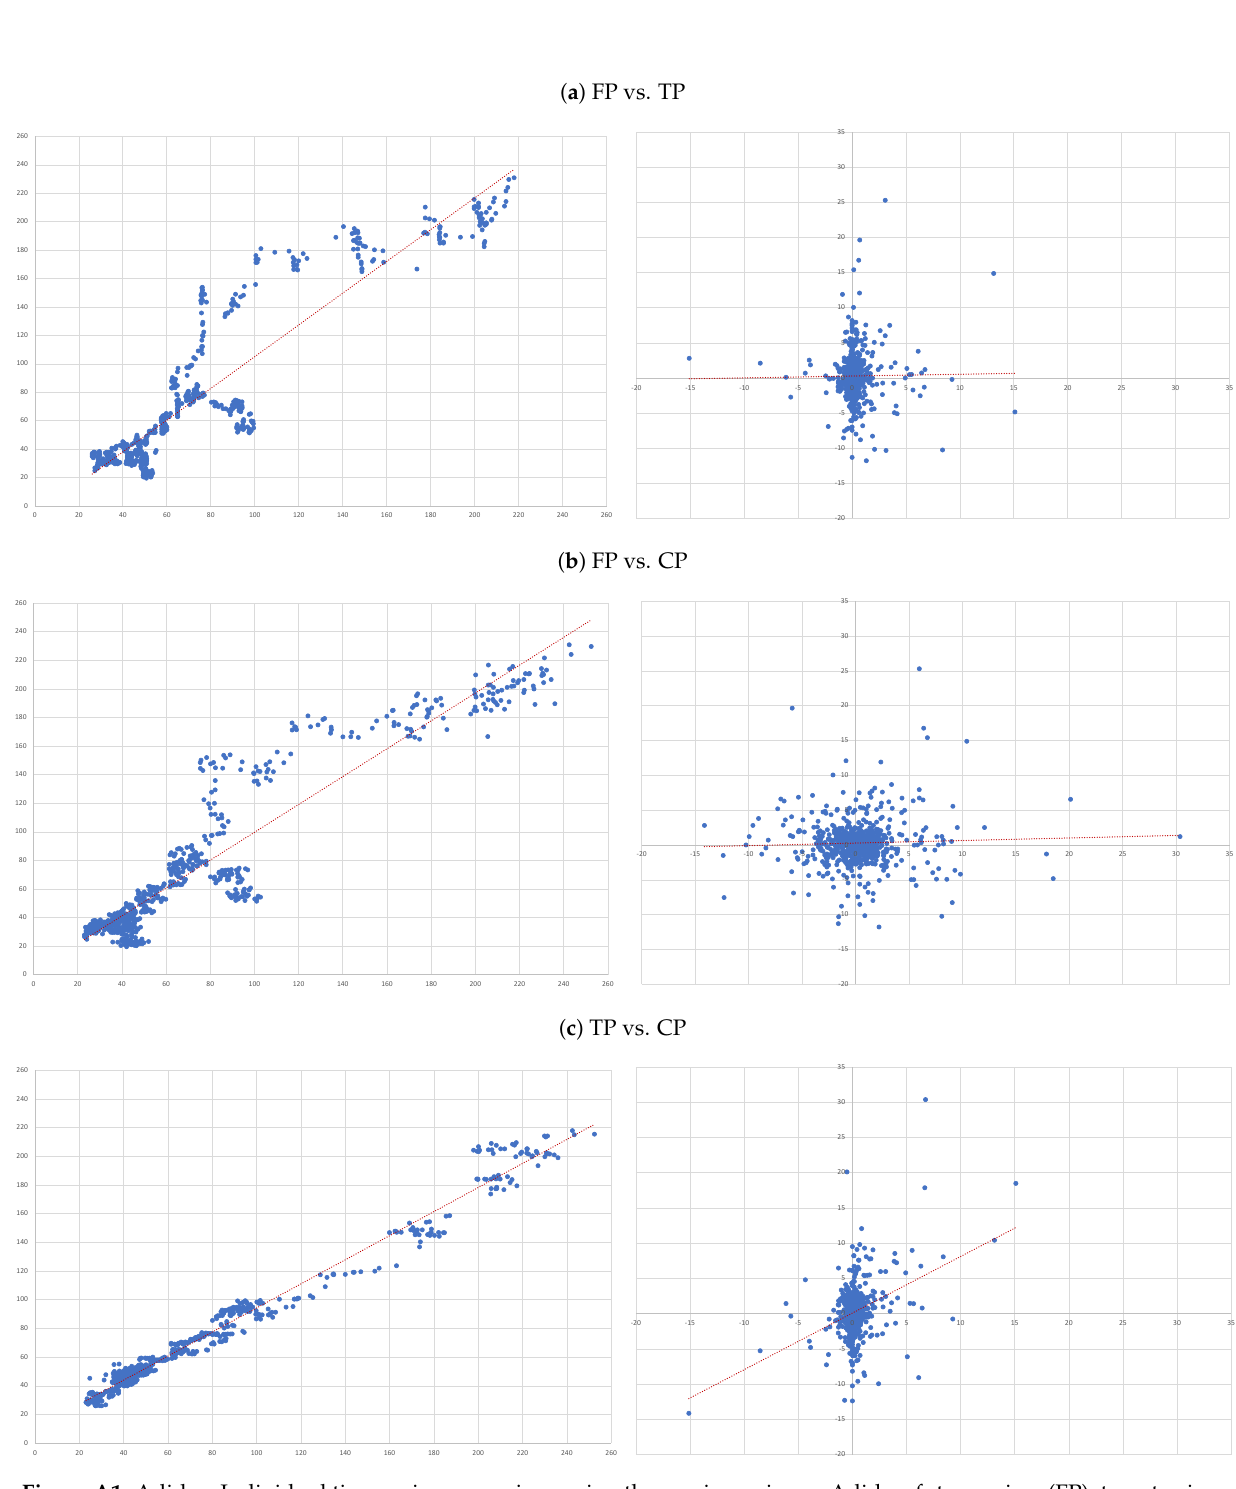
Figure A1. Adidas. Individual time series regressions using three price series on Adidas: future prices (FP), target prices (TP), and capitalised prices (CP) forecasts. On the left-hand-side are images of level regressions and on the right-hand-side are the regressions in